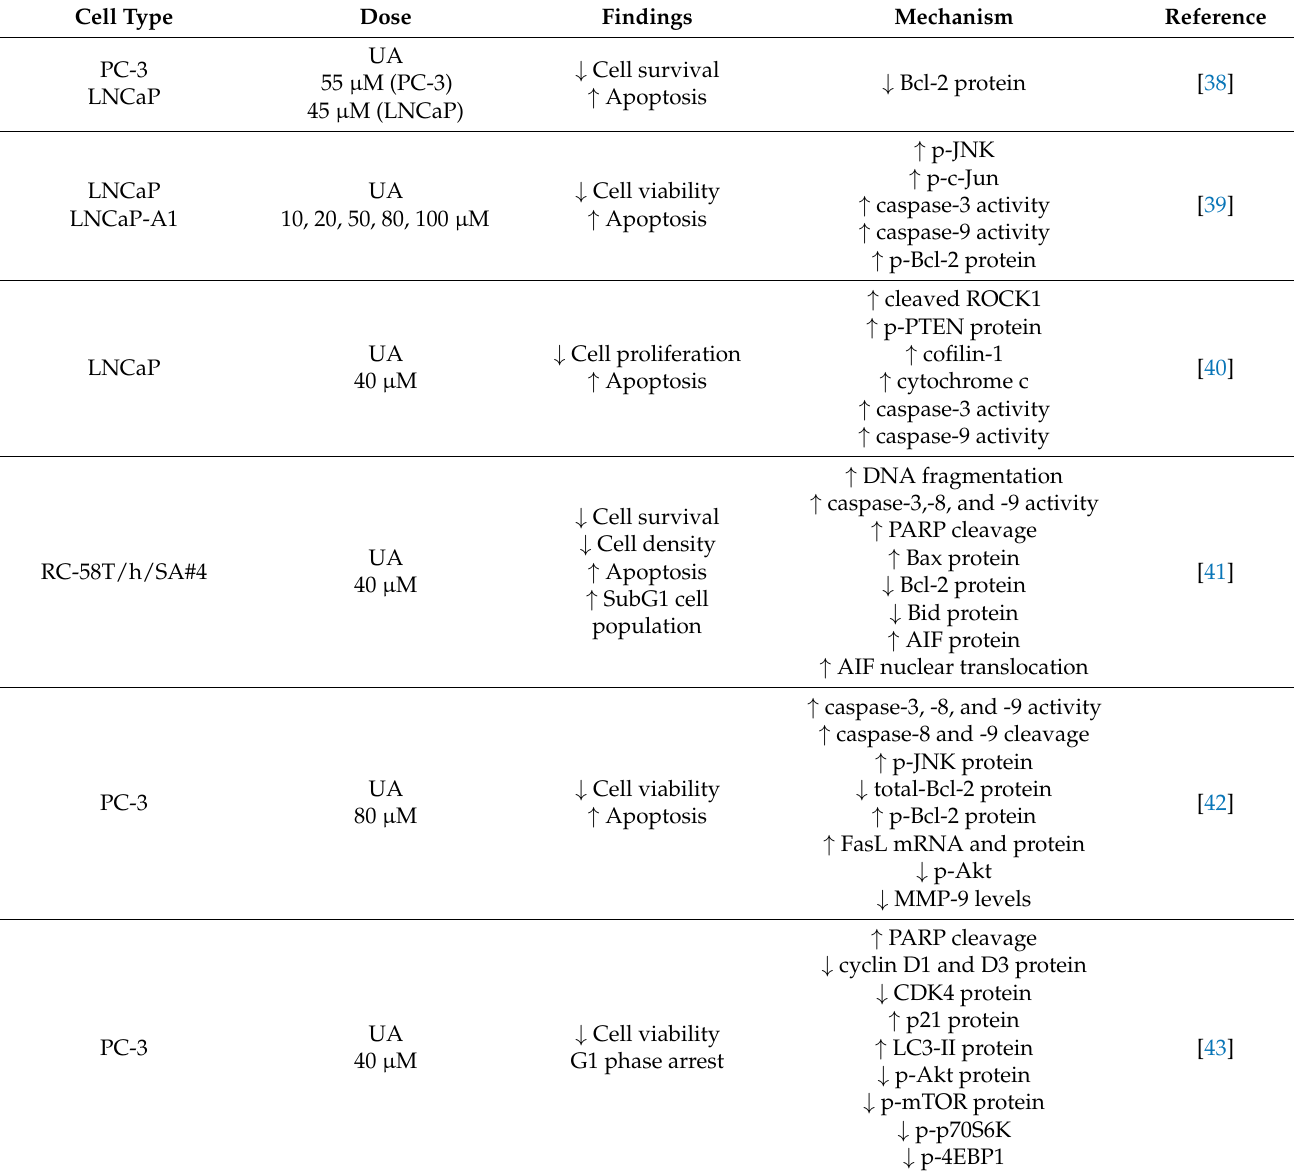
Table 1. Effects of ursolic acid against prostate cancer: summary of in vitro